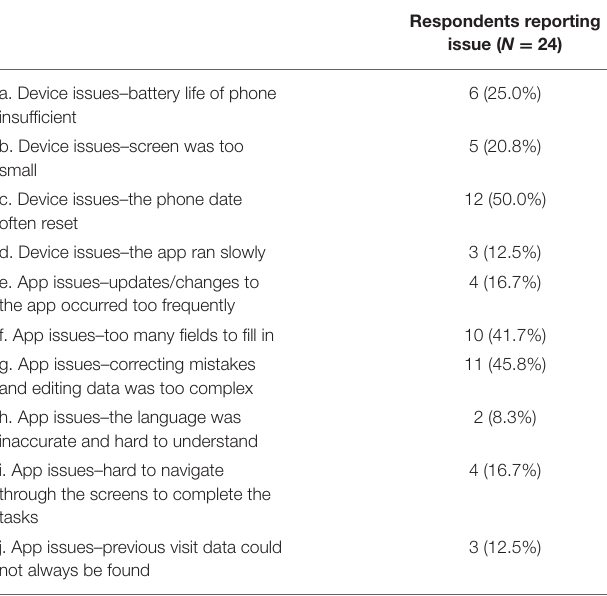
TABLE 4 | Issues reported with POM app during the